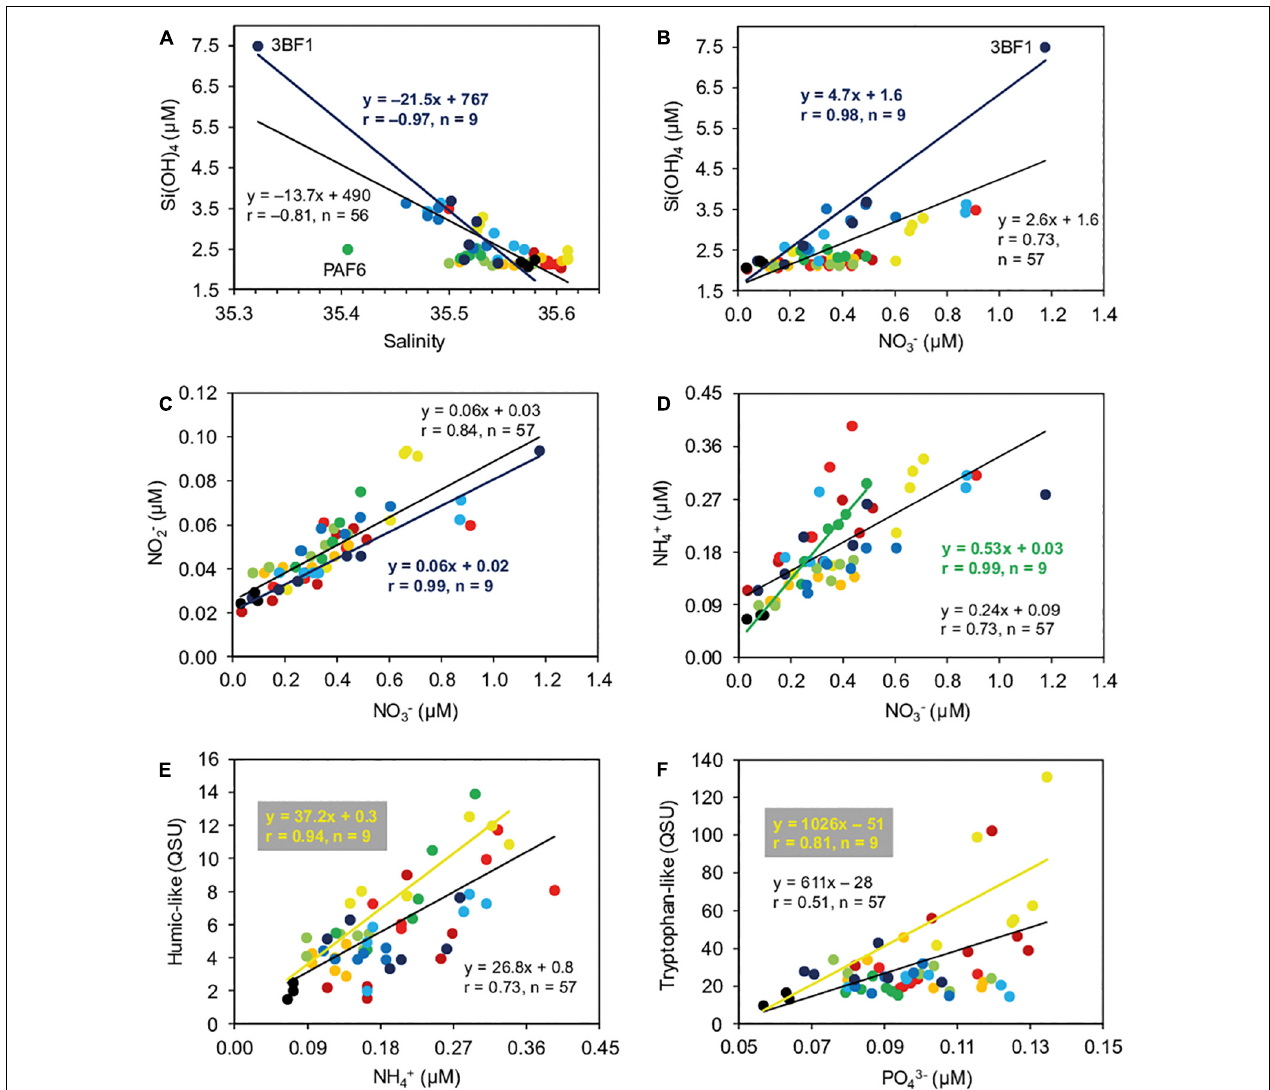
FIGURE 5 | Relationships (Pearson correlations) between salinity and silicate [Si(OH) 4 ] concentration (A) , nitrate (NO 3 - ) and Si(OH) 4 concentrations (B) , NO 3 - and nitrite (NO 2 - ) concentrations (C) , NO 3 - and ammonium (NH 4 + ) concentrations (D) , NH 4 + concentration and fluorescence intensity of humic-like fluorophore (E) , and phosphate (PO 43 - ) concentration and the fluorescence intensity of tryptophan-like fluorophore (F) in fore reef and oceanic waters. Fore reef samples include SGF1-6 (dark red), PMF1-6 (red), TF1-6 (orange), HF1-6 (yellow), CFF1-6 (light green), PAF1-6 (green), BSF1-6 (light blue), SSF1-6 (blue), and 3BF1-6 (dark blue). Oceanic samples include PMO2, PAO1, and 3BO (black). Linear correlations involve all sites and samples [ n = 56 or 57; black lines, for panels (A–F) ], or only one site (the one displaying the highest correlation between variables of interest; see Supplementary Table S5 ) and the oceanic water samples: 3BF and oceanic water samples [dark blue lines, for panels (A–C) ], PAF and oceanic water samples [dark green line, for panel (D) ], or HF and oceanic water samples [yellow lines, for panels (E,F) ].